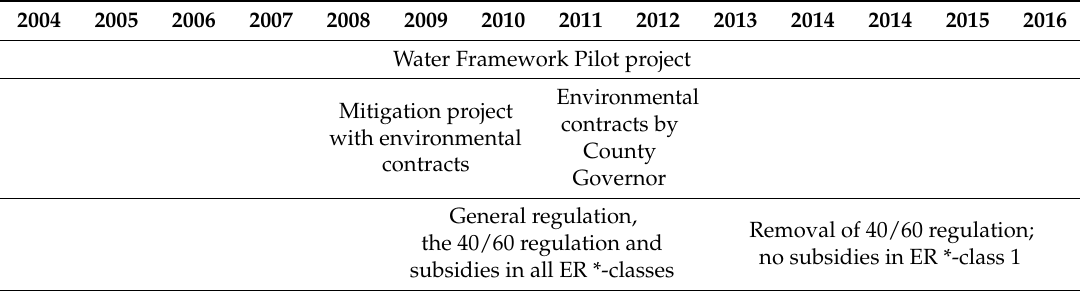
Table 2. The timeline of the pilot project, mitigation project and regulations in the Vestre Vansjø